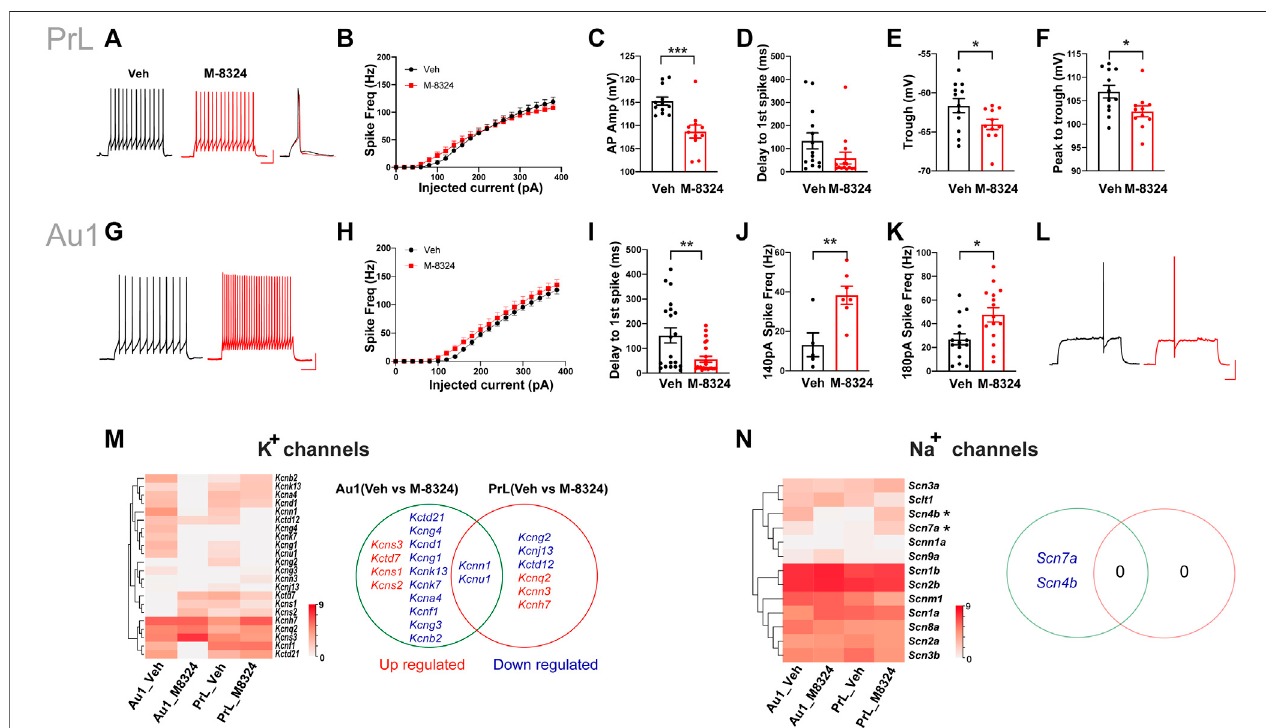
FIGURE3| Changesinintrinsicexcitability,spike properties,expressionofpotassium, and sodiumchannelgenesinPV-neurons inAu1and PrL-PFCafter 7-days M-8324treatment. (A) RepresentativespikepatternsandsinglespikeinPrL-PFCPV-neuronsinVehandM-8324group.Currentinjectionused,160 pAand500 msec. Scale bars, 25 mV/100 ms. (B) Intrinsic excitability of PV-neurons was not different between Veh and M-8324 groups in PrL-PFC. (C) A signi fi cantly lower amplitude of actionpotentialsinPrL-PFCPV-neuronsinM-8324groupcomparedtoVehgroup. (D) Delayto fi rstspikewasnotdifferentbetweenM-8324andVehgroupinPrL- PFC. (E) A signi fi cantly lower trough of action potentials in PrL-PFC PV-neurons in M-8324 group compared to Veh group. (F) A signi fi cantly lower peak to trough of action potentials in PrL-PFC PV-neurons in M-8324 group compared to Veh group. (G) Representative spike patterns in Au1 PV-neurons in Veh and M-8324 group. Current injection used, 140 pA and 500 msec. Scale bars, 25 mV/100 ms. (H) Intrinsic excitability of PV-neurons was not different between Veh and M-8324 groups in Au1. (I) Asigni fi cantlylowerdelayto fi rstspikeinAu1PV-neuronsinM-8324groupcompared toVehgroup. (J) Asigni fi cantlyhigherspikefrequencyinAu1PV-neurons in M-8324group compared toVeh group with 140 pA current injection. (K) A signi fi cantly higher spike frequency in Au1 PV-neurons in M-8324 group compared to Veh group with 180 pA current injection. (L) Representative spike traces showing delay to fi rst spike pattern from Au1 PV-neurons in Veh and M-8324 group. Current injection used, 120 pA and 500 msec. Scale bars, 25 mV/100 ms. (M) (Left) Heatmap of the differentially expressed genes of K + channels between Veh and M-8324 groups inboth Au1andPrL-PFC. (Right) AVenndiagram showing similarities and differencesofthedifferentially expressed K + channel genesafter M-8324 treatmentin Au1 and PrL-PFC. (N) (Left) Heatmap of all detected Na + channel subunits in Veh and M-8324 groups in both Au1and PrL-PFC. (Right) A Venn diagram showing similarities and differences of differential Na + channel subunits after M-8324 treatment in Au1 and PrL-PFC.